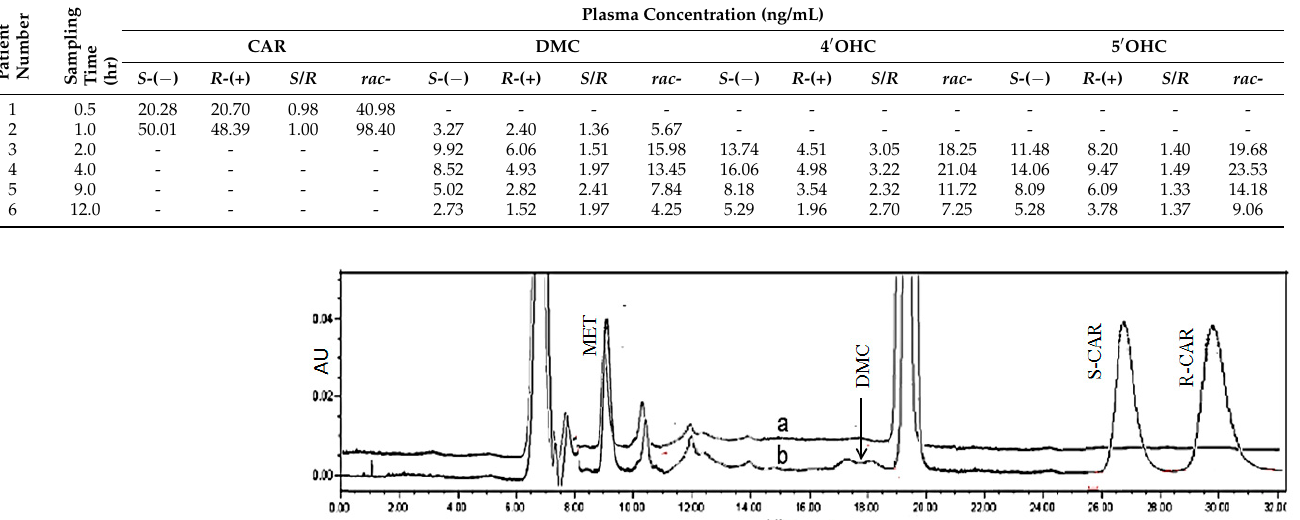
Table 3. Plasma concentrations of CAR and metabolite enantiomers in randomly collected blood samples obtained from cardiovascular patients after oral administration of 25 mg racemic CAR (12.5 mg = 30.75 µ mol per enantiomer) at the respective times of blood sampling.